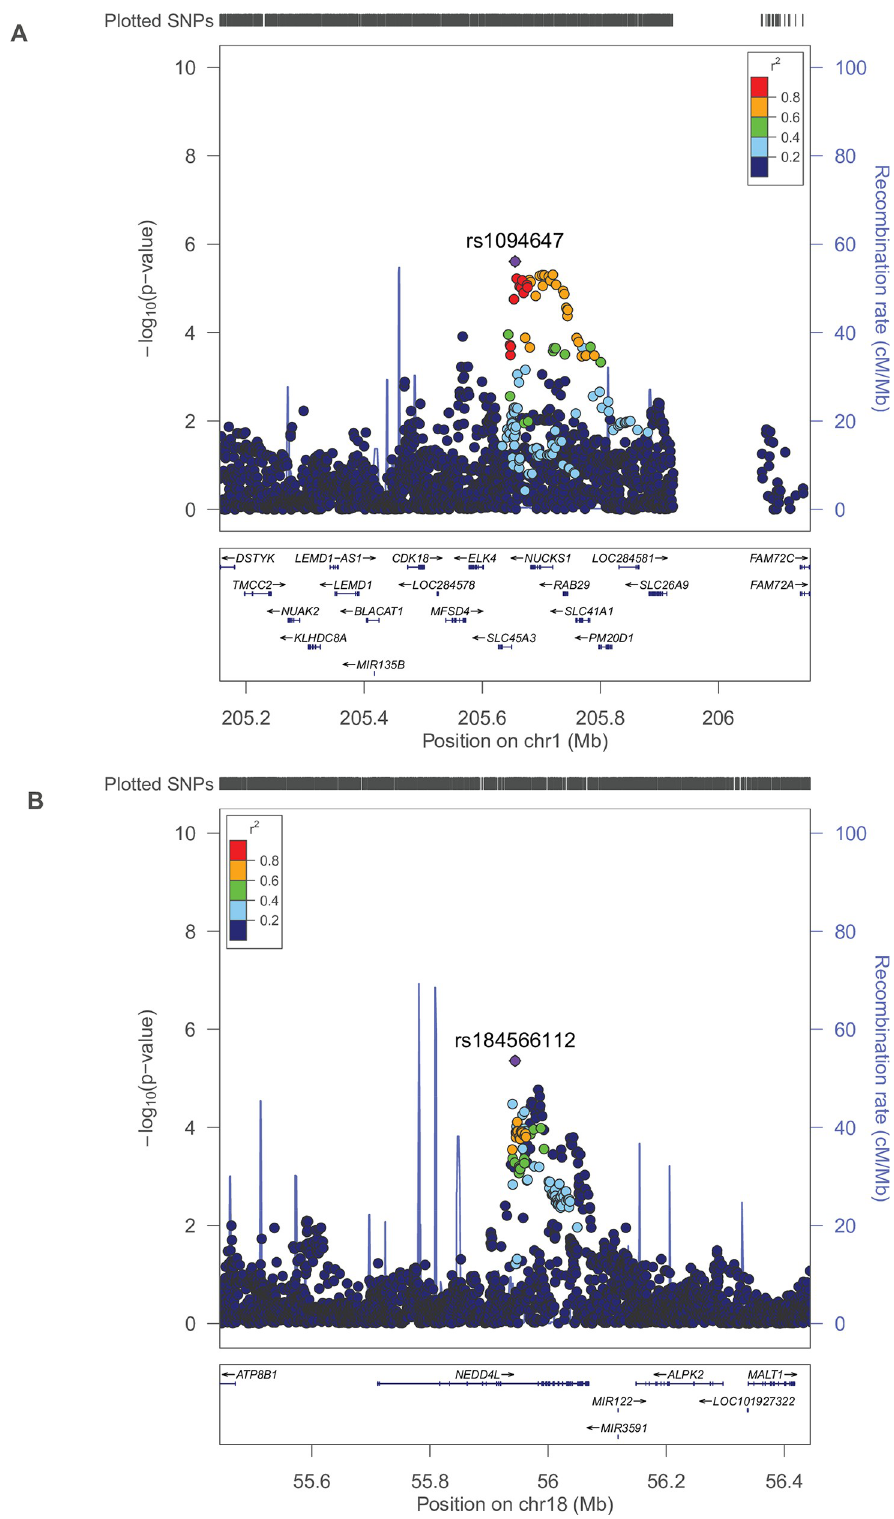
Fig 2. Locus zoom plots of the 2 novel SNPs Regional association plot of the 2 novel SNPs in the 26 childhood BMI discovery studies. SNPs are plotted with their P-values (as–log10; left y-axis) as a function of genomic position (x-axis). Estimated recombination rates (right y-axis) taken from 1000 Genomes, March 2012 release are plotted